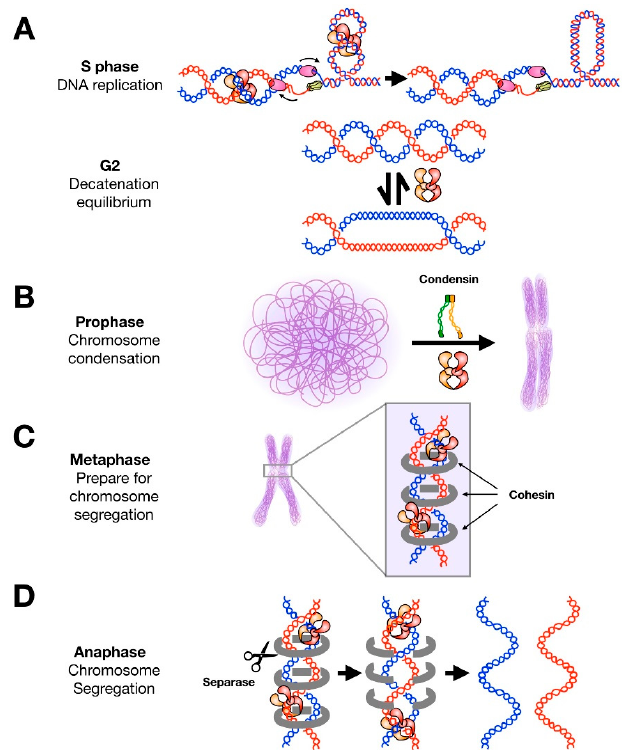
Figure 2. Roles of topo II throughout the cell cycle. ( A ) During DNA replication, topo II decatenates newly-replicated sister chromosomes and aids in relaxing positive supercoils that accumulate ahead of replication forks. Most decatenation is complete upon entry into prophase. Topo II can operate bidirectionally and is still present in high concentrations during G2; it has been suggested that the enzyme may contribute to maintaining a catenated state of sister chromosomes to assist chromosome condensation and cohesion without subsequently interfering with segregation. ( B ) Condensin and topo II are both required for e ffi cient condensation of chromosomes in prophase. ( C ) In metaphase, topo